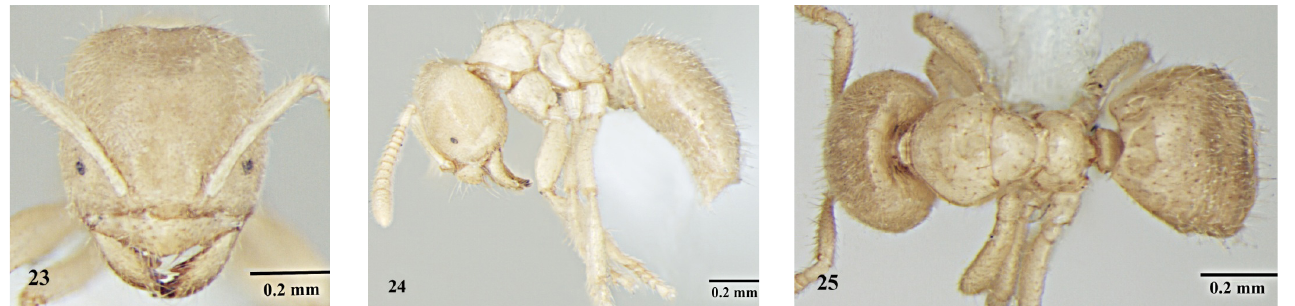
Fig. 23-25 . Pseudolasius polymorphicus sp. n ., minor worker 23) head, full face view; 23) body, lateral view; 25) body, dorsal view.